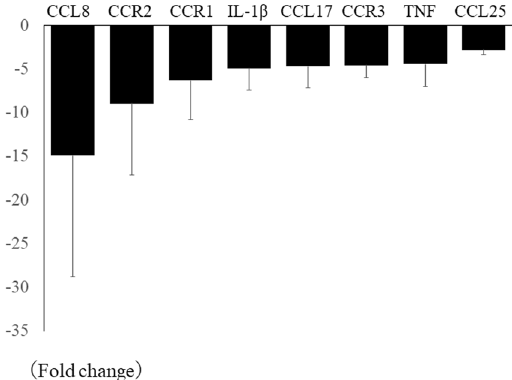
Figure 4. Pro-inflammatory chemokine and cytokine gene expressions are suppressed in NLRP3 KO mice cornea after alkali injury. Several pro-inflammatory chemokine and cytokine gene expressions, CCL8 ( − 14.9 ± 13.9 fold), CCR2 ( − 8.9 ± 8.1 fold), CCR1 ( − 6.3 ± 4.4 fold), IL-1 β ( − 4.9 ± 2.5 fold), CCL17 ( − 4.7 ± 2.5 fold), CCR3 ( − 4.6 ± 1.4 fold), TNF ( − 4.4 ± 2.6 fold), and CCL25 ( − 2.8 ± 0.5 fold) are down- regulated in NLRP3 KO mice cornea compared with those in WT mice using PCR